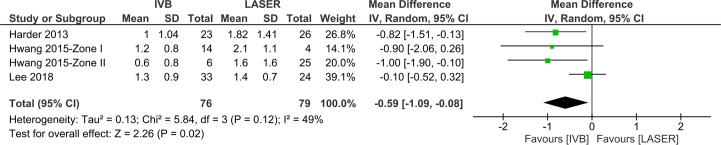
Forest plot of the comparison of astigmatism in cylinder power between IVB and laser treatments.Pooled estimates for mean differences and 95% CI in diopters between two treatments. The black diamond symbol on the bottom row shows the estimated true effect size.